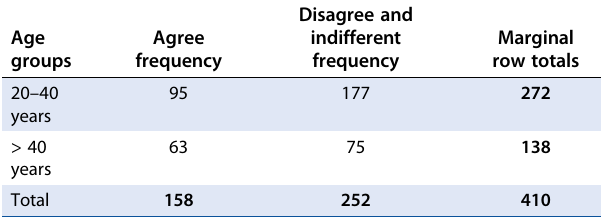
Table 1: Baseline characteristics Table 3: Age and being valued by the team members ( n =